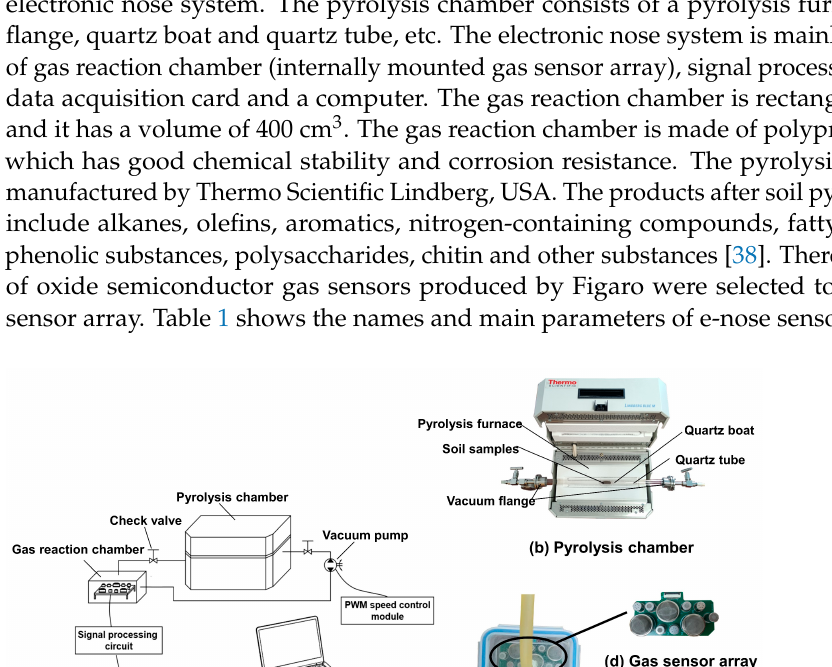
Figure 2. Frequency histogram of SOM content.